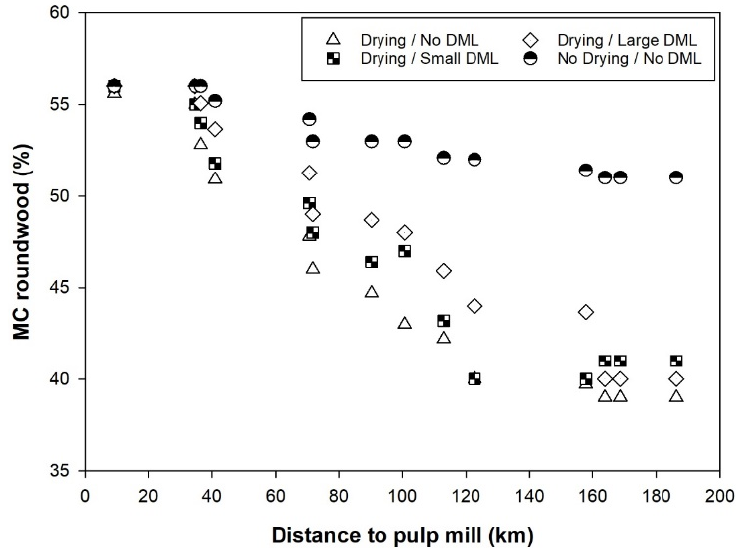
Figure 5. Relationship between MC and distance to the pulp mill by